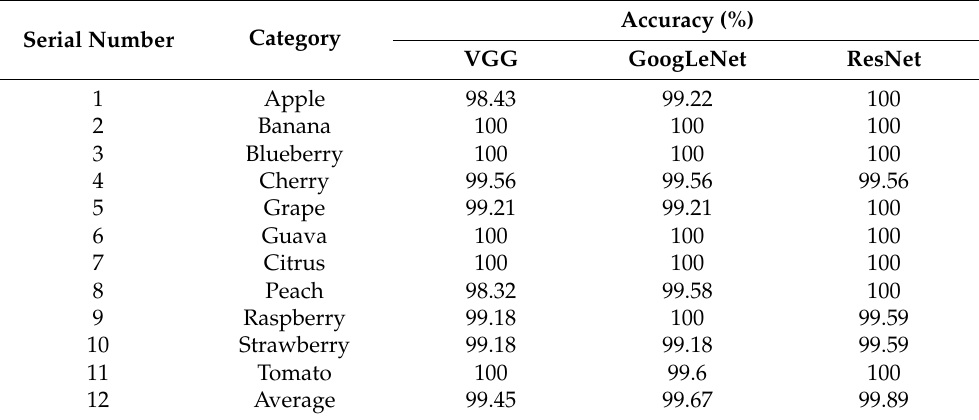
Table 5. The accuracy of the models on the test